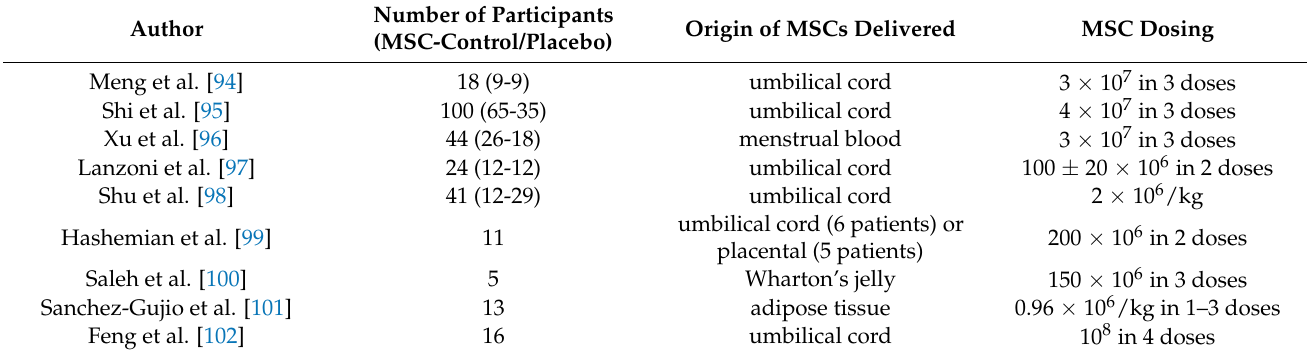
Table 2. Clinical trials of MSC treatment of